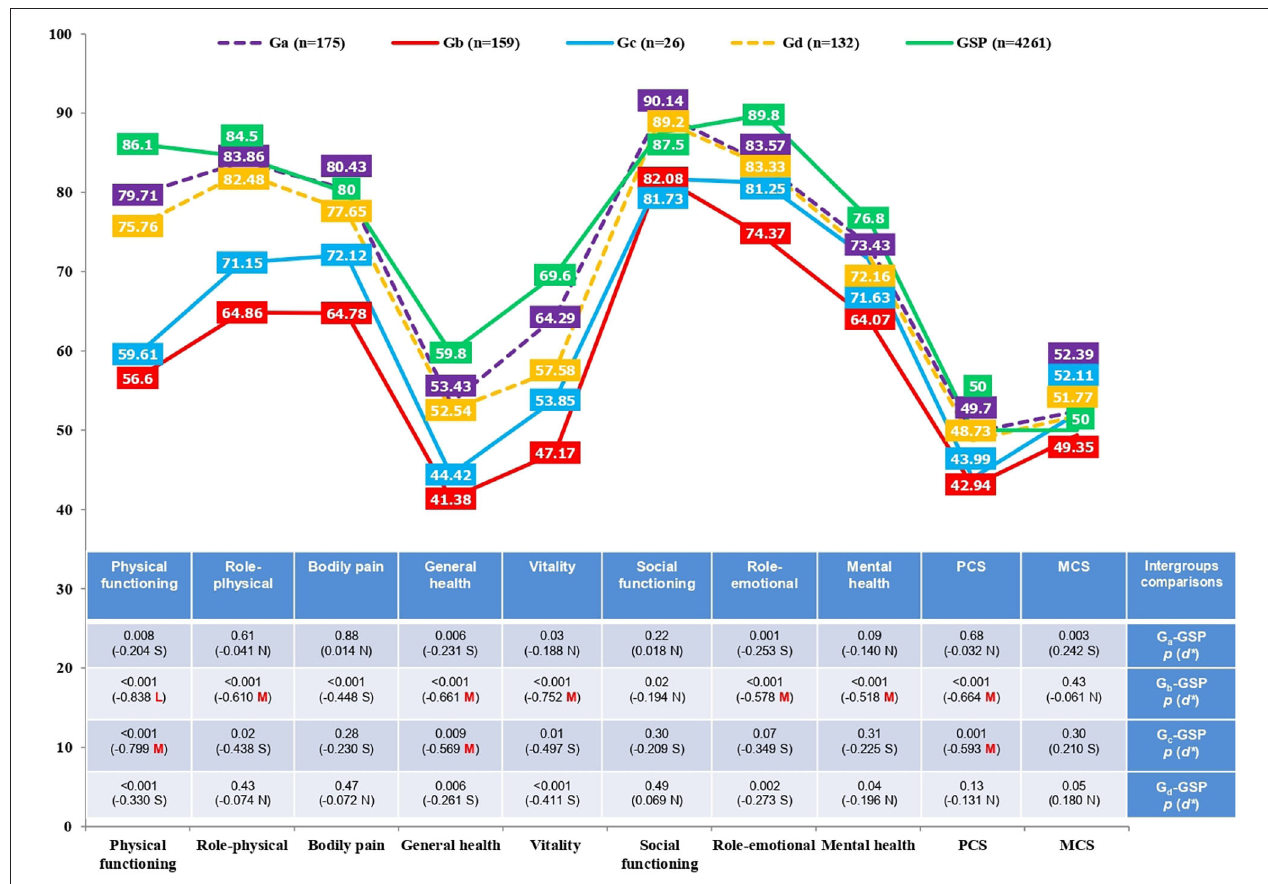
FIGURE 3 | Comparison of quality of life (SF-12) in the non-alcoholic fatty liver disease (NAFLD) severity groups and the general Spanish population (GSP). *Cohen’s d : N , null effect size; S , small effect size; M , medium effect size; L , large effect size. G a , no-NASH without significant fibrosis; G b , NASH with significant fibrosis; G c , no-NASH with significant fibrosis; G d , NASH without significant fibrosis; GSP , general Spanish population; PCS , physical component summary; MCS , mental component summary; SF-12 , 12-Item Short-Form Health Survey.